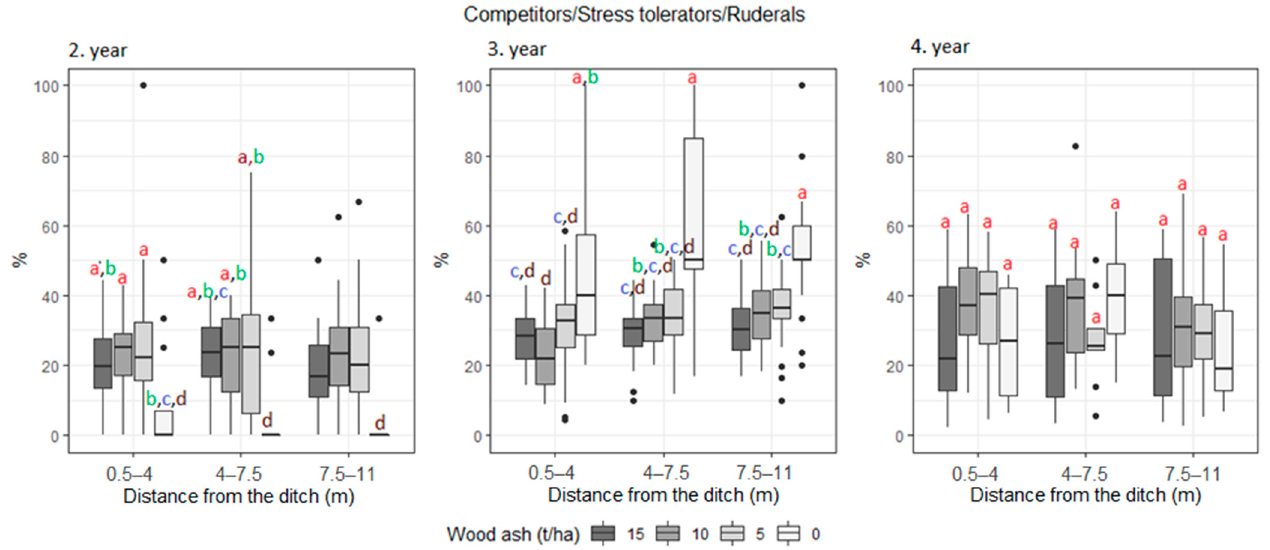
Figure A7. Relative cover of plants with competitor/stress tolerant/ruderal (no-specific strategy) universal adaptive strategy from the total vegetation cover, depending on the distance from the drainage ditch and the dose of wood-ash fertiliser. Different letters (a, b, c, d) indicate significant differences between groups, p < 0.05 according to the Tukey HSD test.